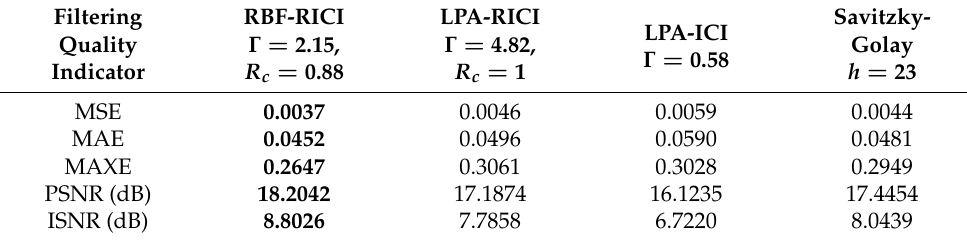
Table 15. Doppler signal (SNR = 5 dB)—Filtering